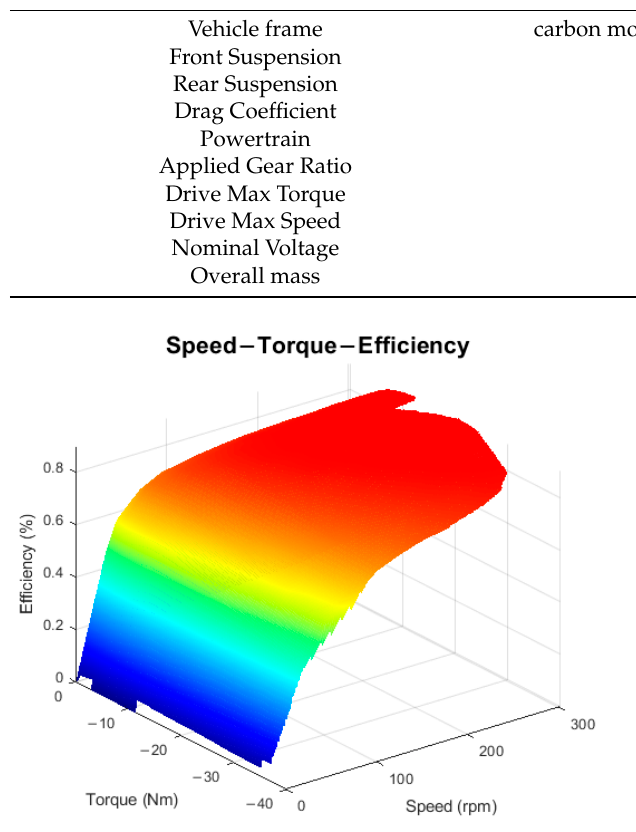
Figure 2. Measured speed − torque − efficiency map of SZEVOL2.